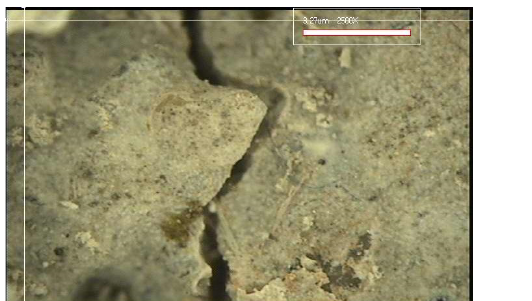
Figure 16. Correlation between healing period and healing rate on the MCs 0%.